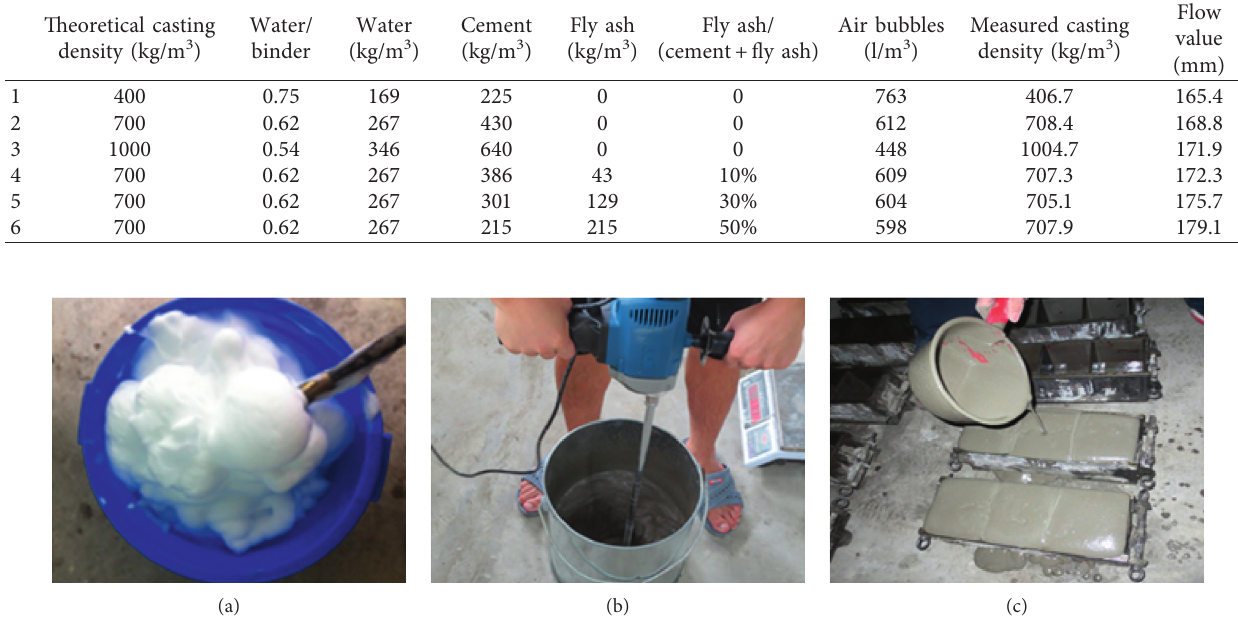
Figure 2: Preparation of the foamed concrete slurry [25].